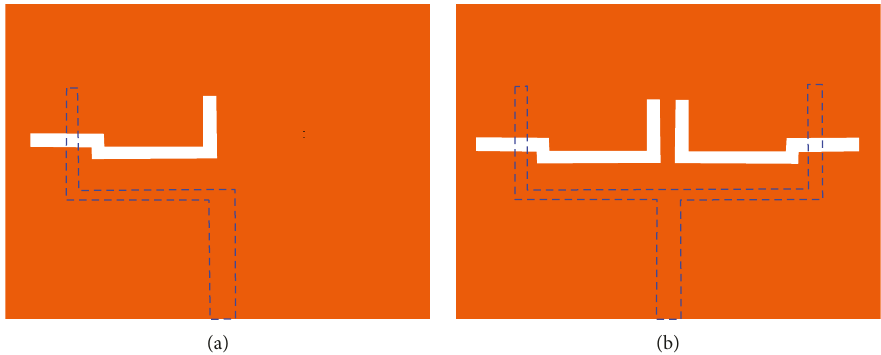
Figure 6: Slot antennas with asymmetric and symmetric structures. (a) Antenna 1. (b) Antenna 2.